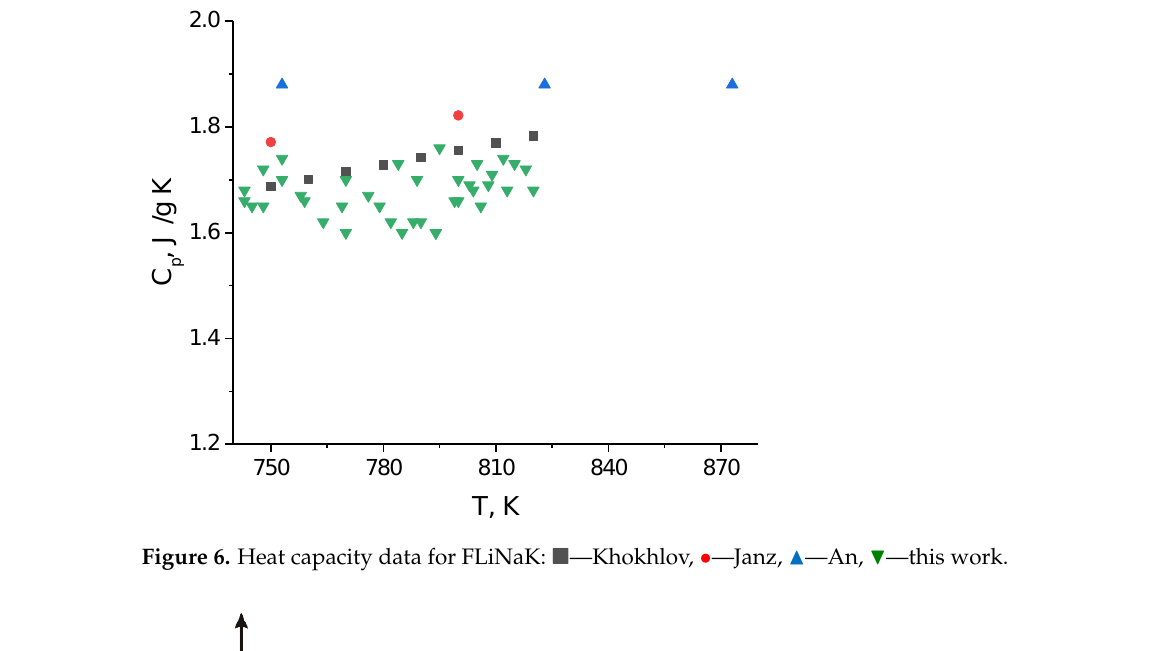
Figure 5. DSC results for FliNaK at different heating rates.